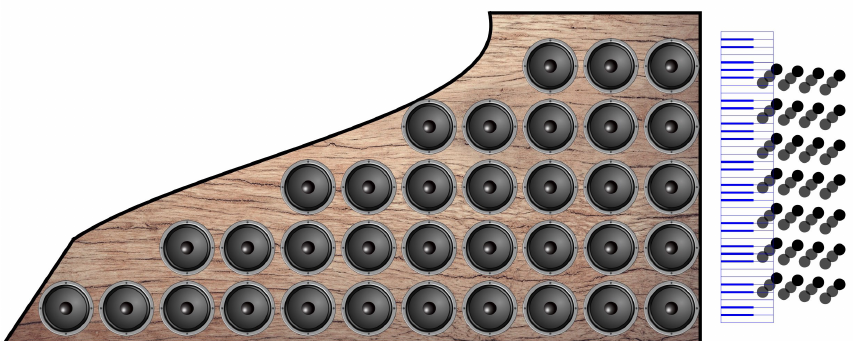
Figure 4. Depiction of the radiation keyboard. A regular grid of loudspeakers is installed on a board. The board has the shape of the harpsichord sound board. Microphones (black dots) sample the listening region in front of the